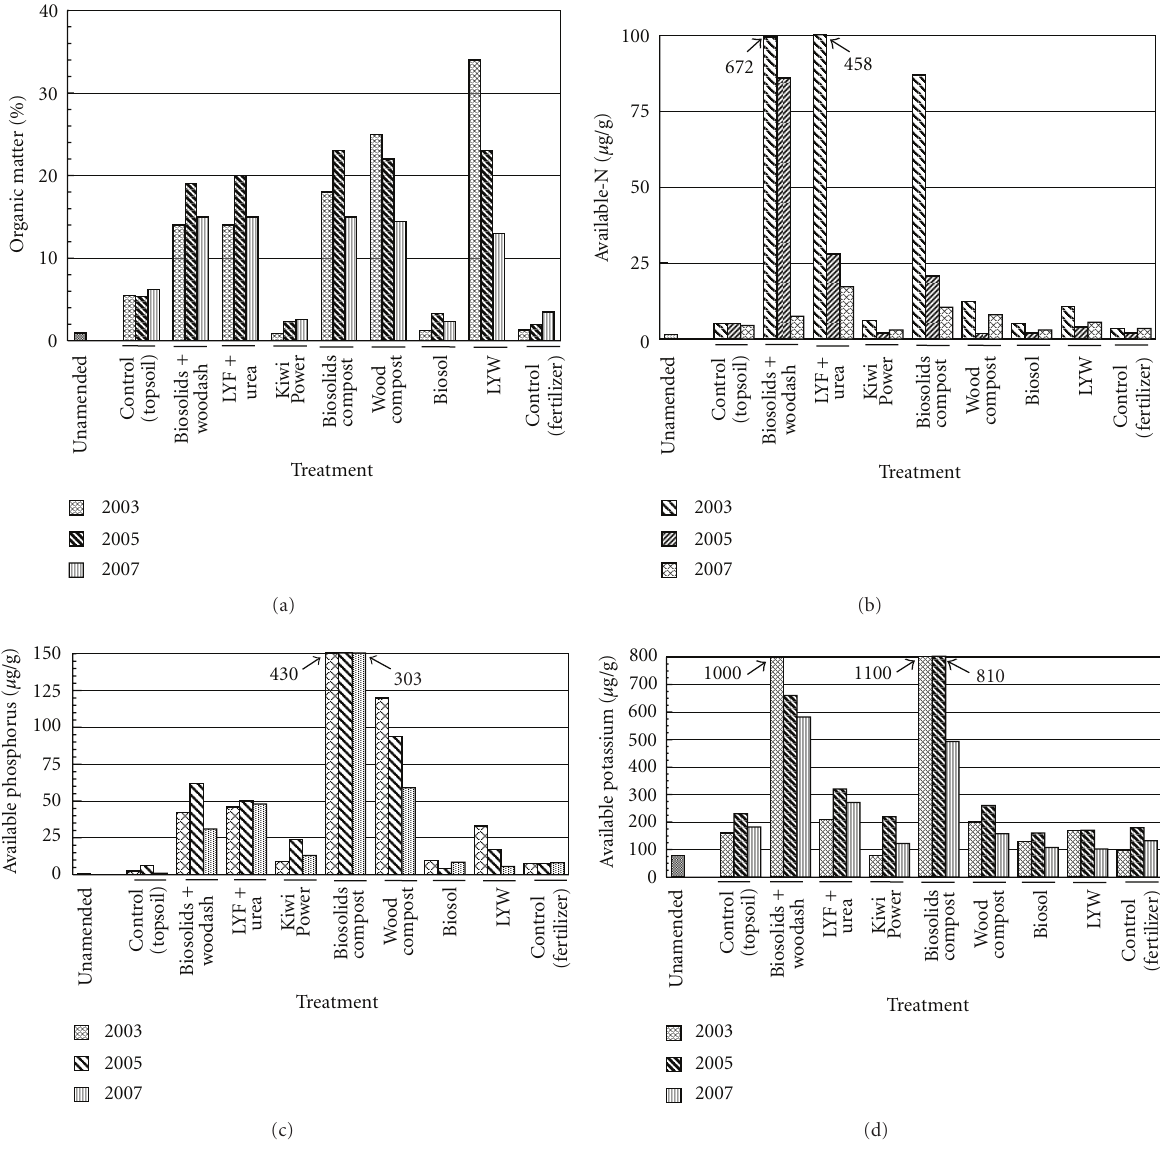
Figure 1: Trends in (a) organic matter content, (b) available N, (c) available phosphorus, and (d) available potassium in the unamended and treated plots for years 2003, 2005, and